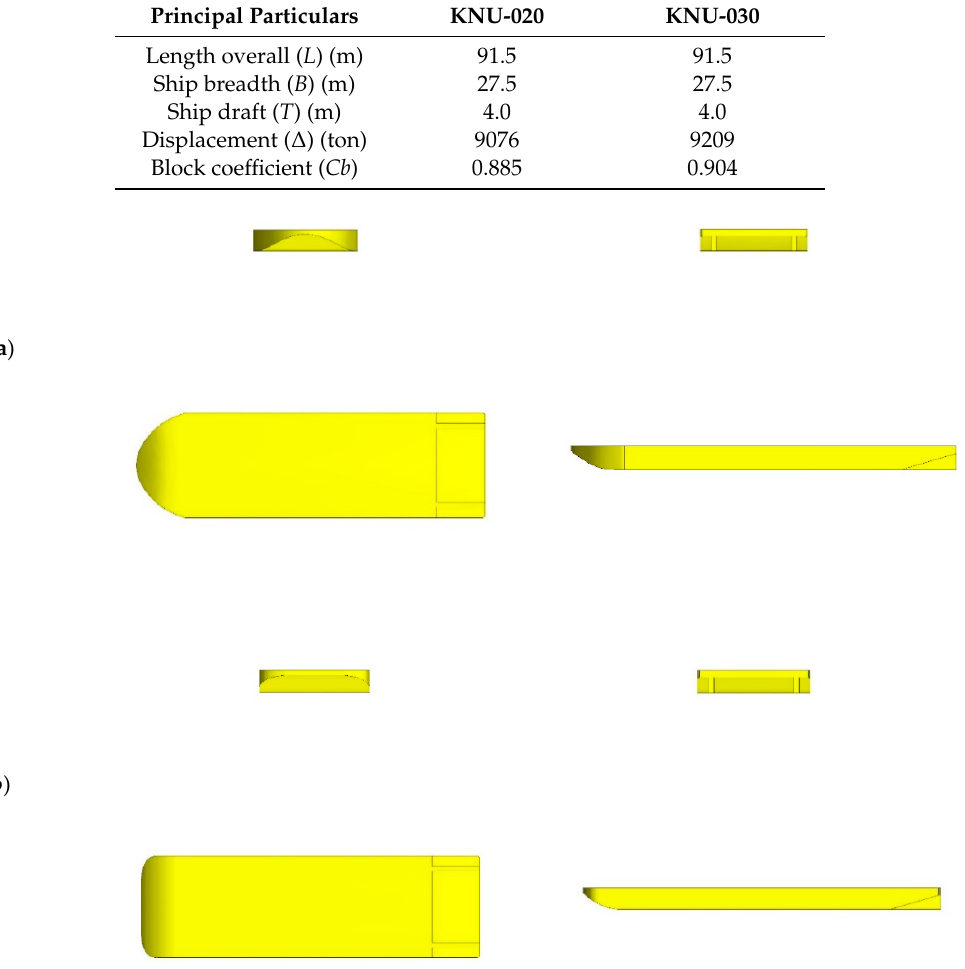
Figure 3. View of front, rear, bottom, and side: ( a ) KNU-020; and ( b )